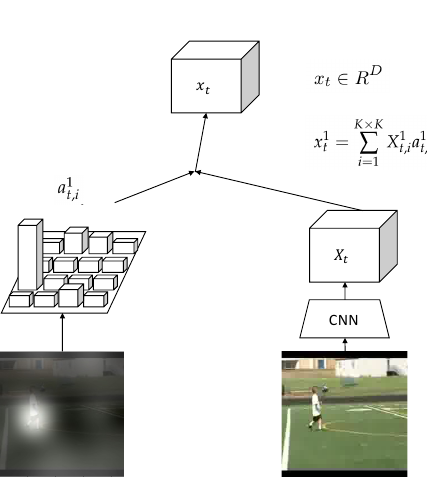
Figure 2. The illustration of attention process. a 1 refines the input of first layer of LSTM through attention